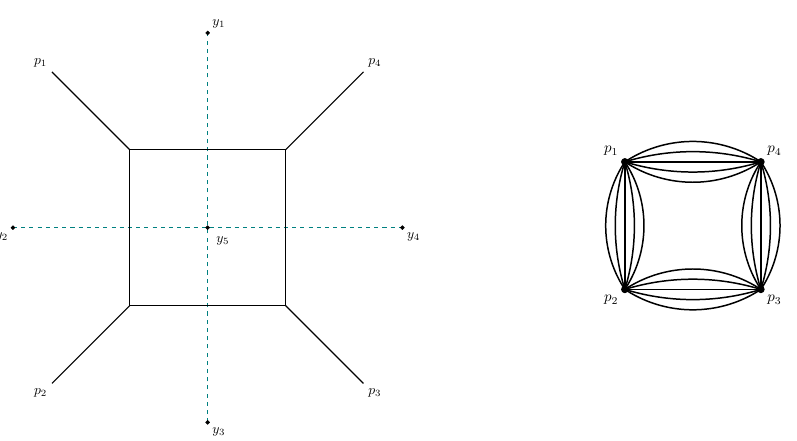
Figure 1 . The box with its dual (left) and its higher scaling version (right). While the (cid:12)rst is conformal for d 6 = 2 in ordinary conformal coordinates and for d = 4 in dual coordinates, the right one is not conformal in coordinate and dual coordinate space at the same